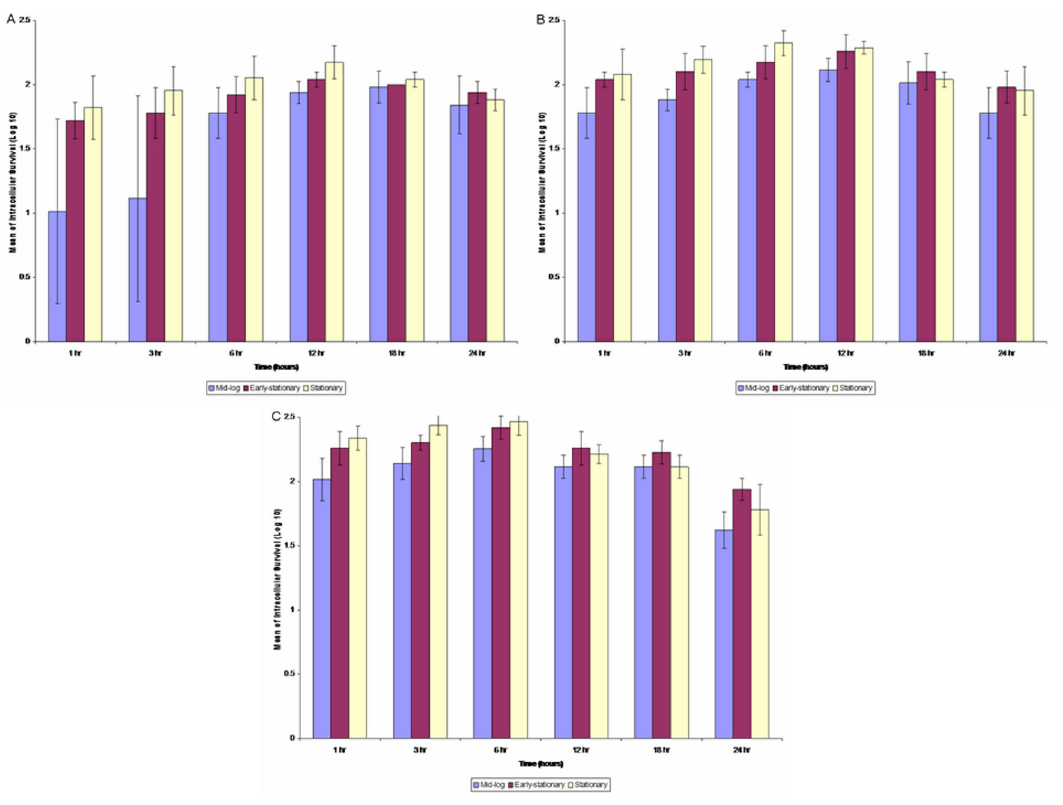
Figure 2. The intracellular survival assay of B. cepacia (mid-logarithmic, early-stationary and stationary phases of growth) after 3 hours of post-infection with MOI of (panel A) 1:10, (panel B) 1:50 and (panel C) 1:100 at different phases of growth. The error bars indicate the standard deviation of triplicate values.